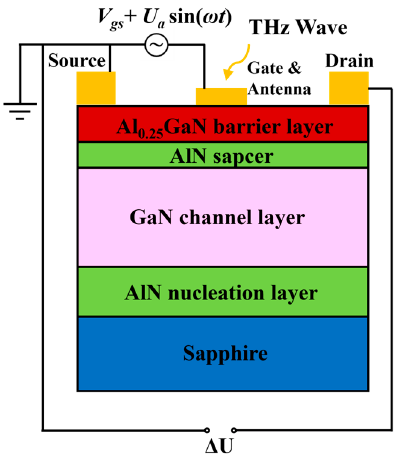
Figure 1. Diagram of a typical GaN HEMT THz detector and equivalent circuit diagram for THz wave detection. THz wave is collected by antenna connected to gate electrode, and response voltage ∆ U is generated between source and